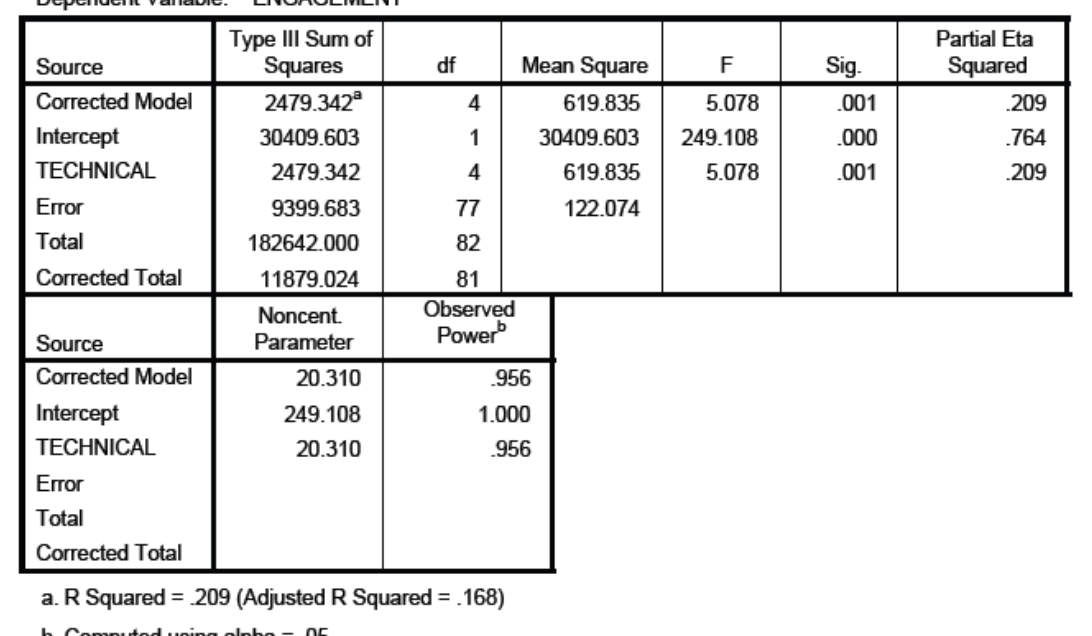
Figure B.1. ANOVA analysing engagement levels in regard to technical